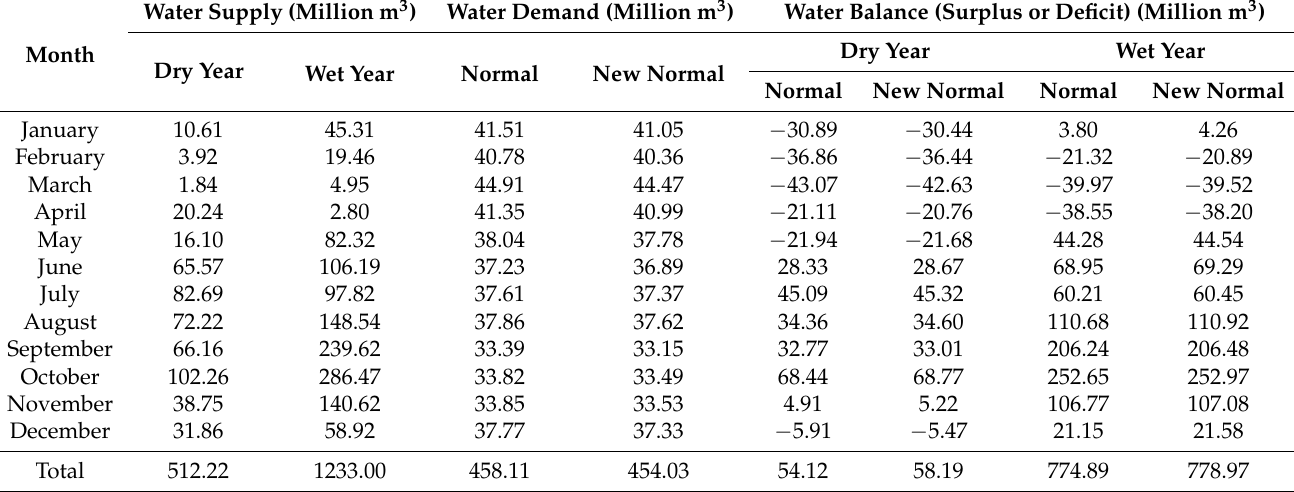
Table 25. Monthly water supply and demand balance evaluation without consideration of ecological water requirements between 2020 and